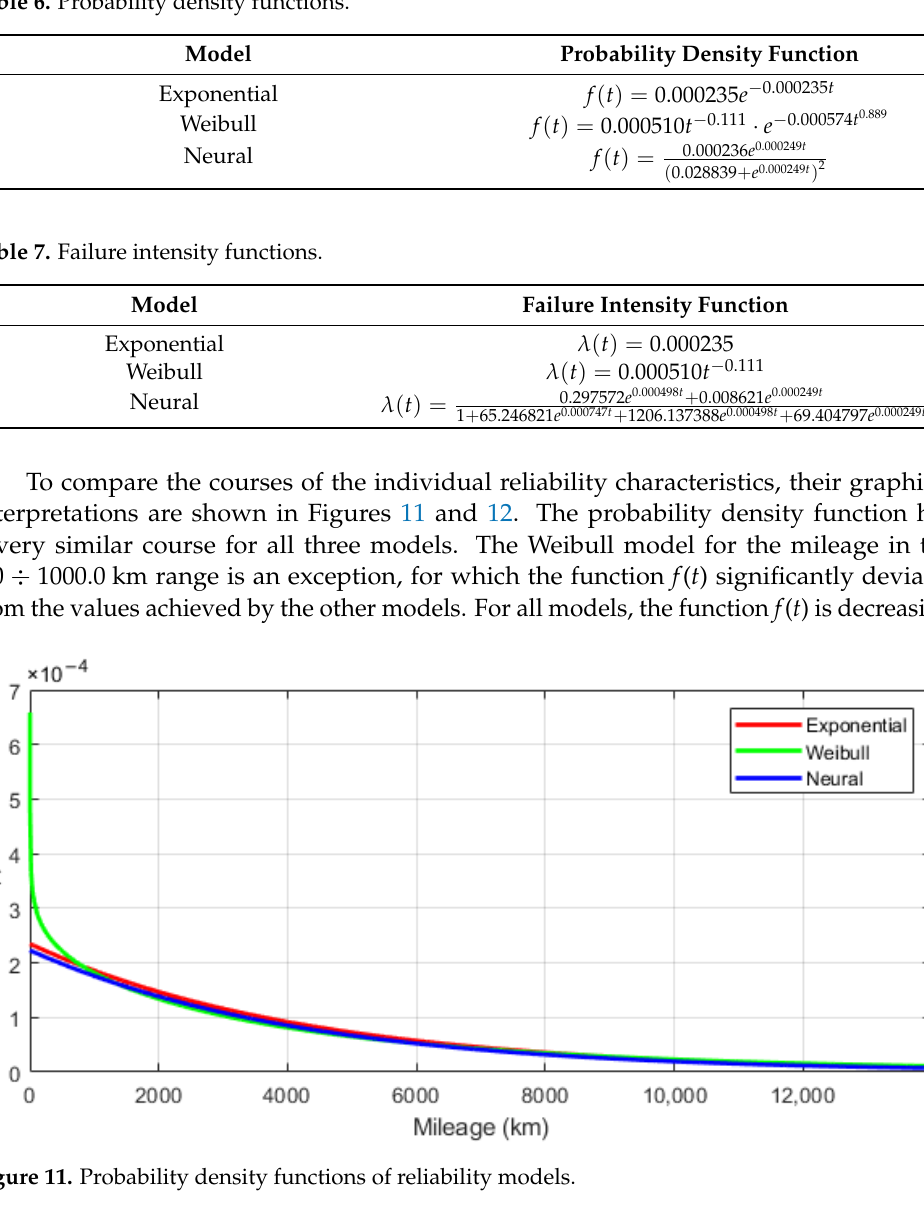
Figure 12. Failure intensity functions of reliability models. Figure 13 presents a plot showing the value of the integral of the reliability function over the integration interval [0.0, t ] for t ≤ 100,000.0 km. The calculated definite integral in the interval from 0.0 to infinity corresponds to the expected value of the mileage between failures. For the exponential and Weibull model, the expected value of ET is finite and is 4255.32 km and 4686.22 km, respectively (Table 8). For the neural model, the expected value of the mileage between failures approaches infinity. The use of the model, therefore, requires the implementation of appropriate constraints due to the inability of the neural network to extrapolate the value of the reliability function beyond the known data range. The empirical data for which the value of the reliability function was estimated range be- tween [0.0; 21,477.0 km]. In this range, the ET value for the neural model attains similar levels to the Weibull model.